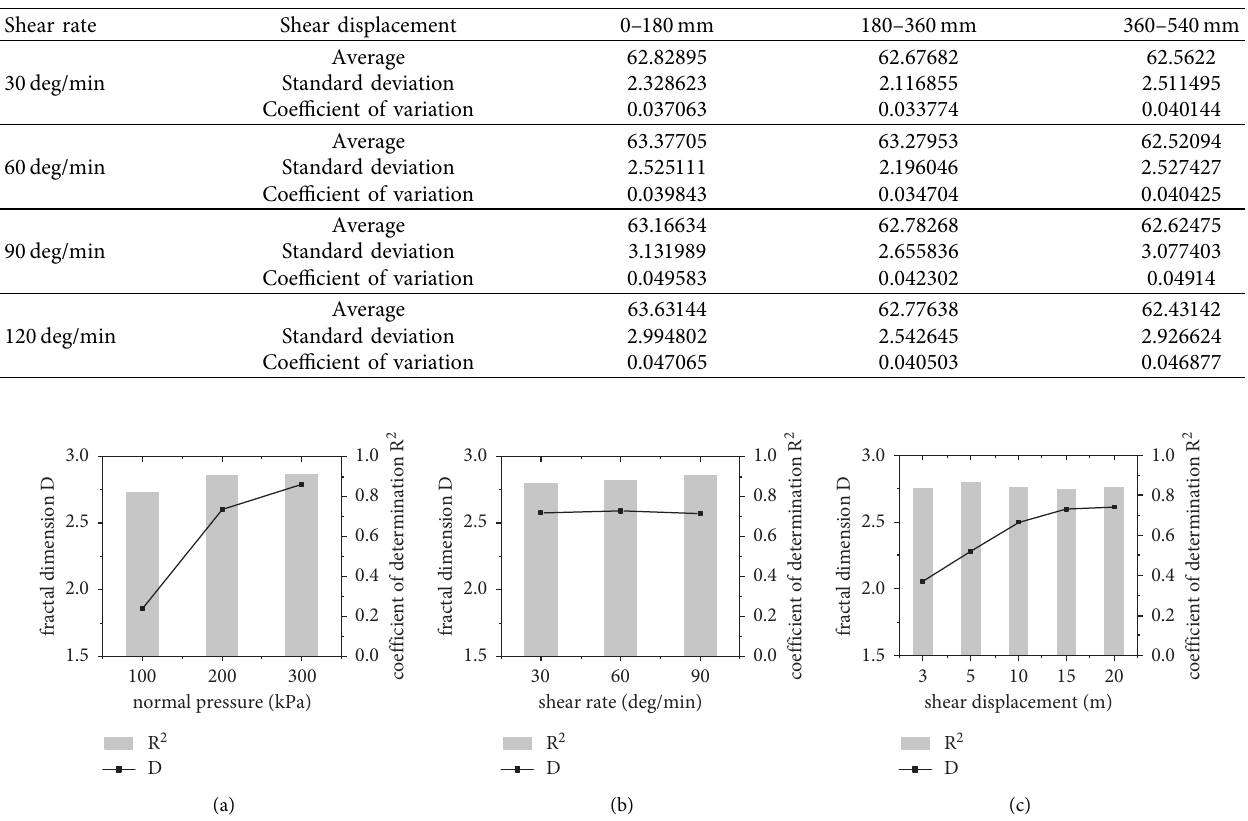
Figure 11: Fractal dimension under different shear conditions. (a) Fractal dimension after shearing 15 m at a shear rate of 60deg/min and normal stresses of 100 kPa, 200 kPa and 300kPa. (b) Fractal dimension after shearing at 15m at a shear rate of 30deg/min, 60 deg/min, and 90 deg/min under a normal stress of 200kPa. (c) Fractal dimension at a shear rate of 60deg/min and a normal stress of 200kPa after shearing at 3 m, 5m, 10 m, 15m, and